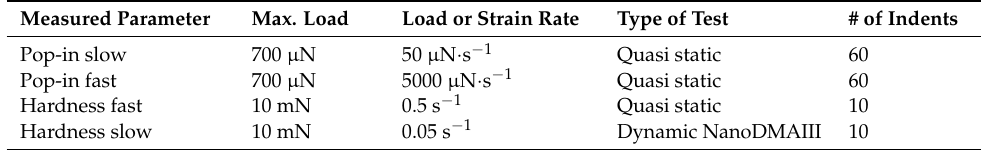
Table 1. Nanoindentation parameters.